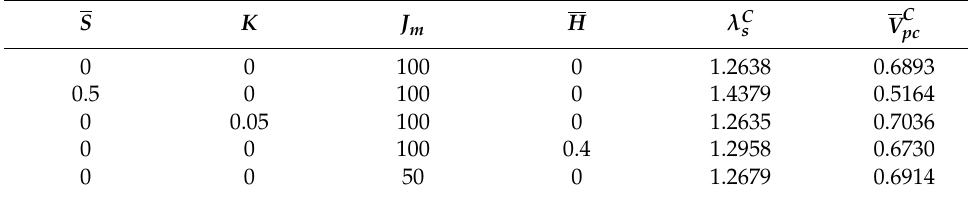
Table 2. The static critical voltage V C DC and static critical stretch λ C s